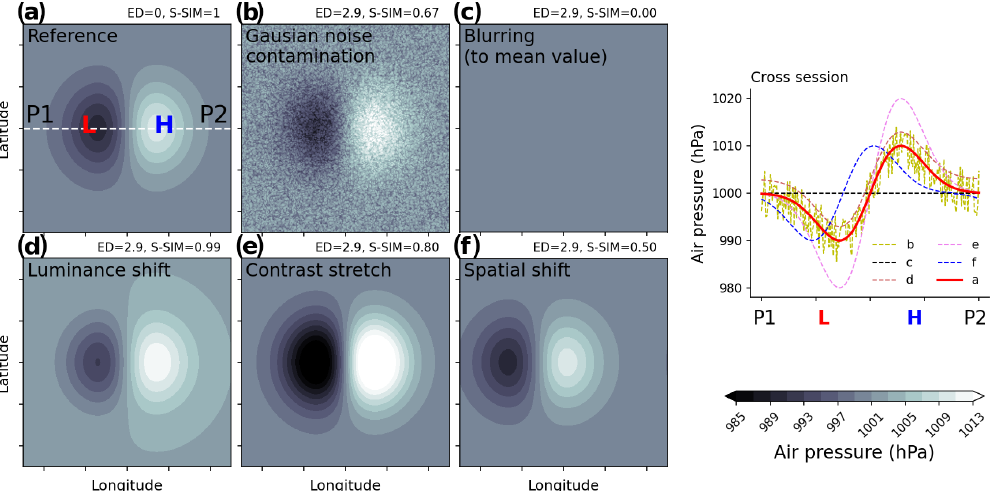
Figure 8. Imagination air pressure patterns. Subpanels are the reference (a) , Gaussian noise contamination (b) , blurring (to mean value) (c) , luminance shift (d) , contrast stretch (e) , and spatial shift (f) . The ED (Euclidean distance) and S-SIM (structural similarity) values shown above each panel are those calculated with respect to the reference one (a) . The rightmost subpanel shows the cross section (between two points P1 and P2 in a ), with L and H indicating the location of imagination low and high air pressure